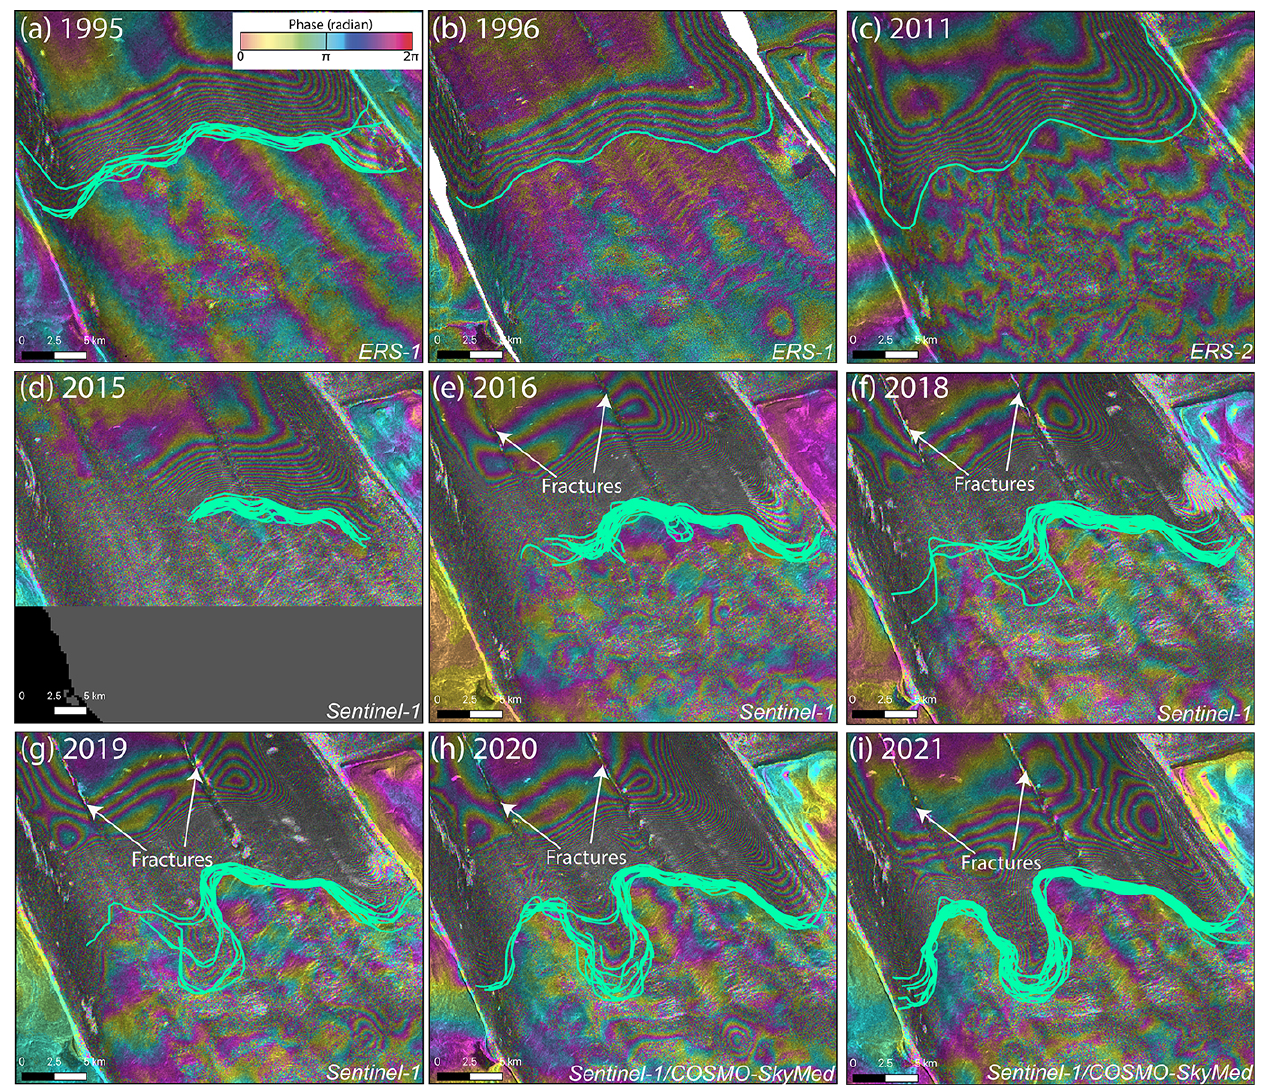
Figure 2. Selection of double-difference SAR interferograms of Petermann Glacier, Greenland, collected between 1992 and 2021. Solid light green lines indicate the digitized grounding line positions for a given year. White arrows show the location of across-shelf